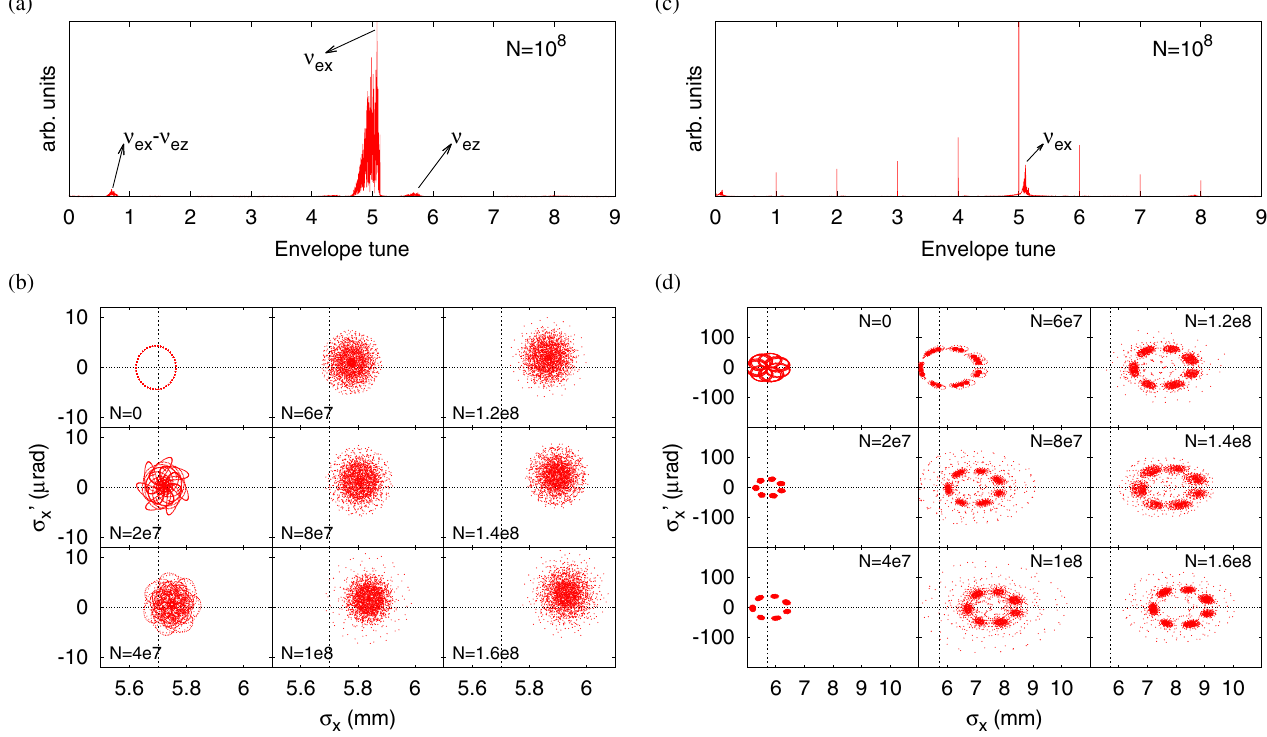
FIG. 2. The FFT spectrums of horizontal beam envelope (a) without and (c) with quadrupole errors. Envelope phase space with different densities (b) without and (d) with quadrupole errors. The ring is 324-m, 18-FODO cells ring with ν x ¼ 2 . 6 , ν z ¼ 2 . 95 . The quadrupole error is Δ K 1 L ¼ 0 . 01 m − 1 at β x ¼ 17 . 5 m and β z ¼ 21 . 5